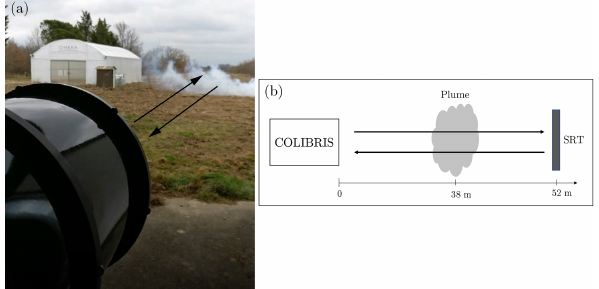
Figure 8. Experimental setup in a horizontal configuration. A fog- oil plume is generated between the lidar and the Lambertian SRT. (a) Photo and (b) illustration of the experimental setup with fog-oil plume.